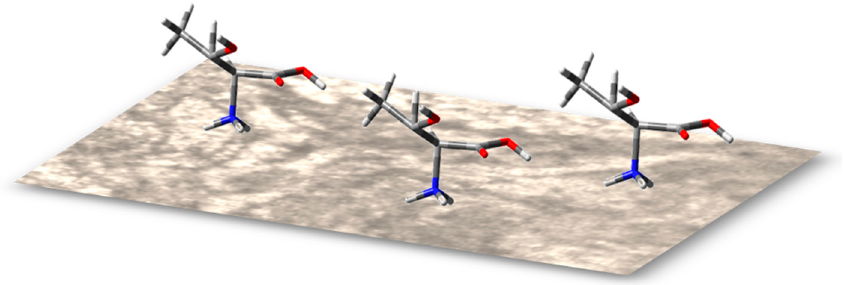
Figure 6. The schematic orientation of Thr (10 − 1 M) onto the CuNPs-Fe surface in a corrosive